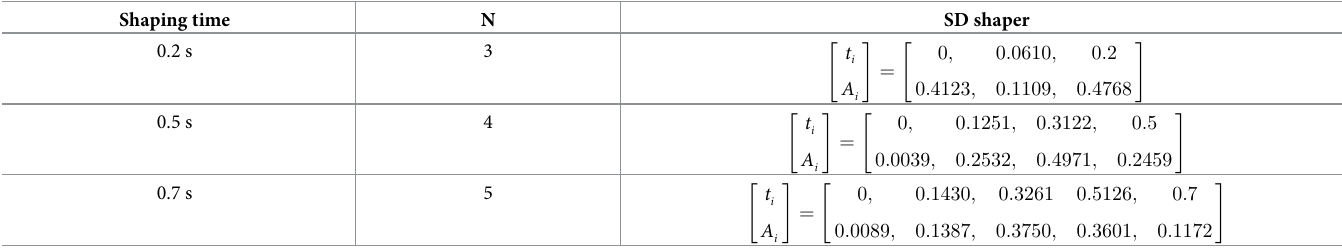
Table 2. Obtained SD shapers with three shaping times.